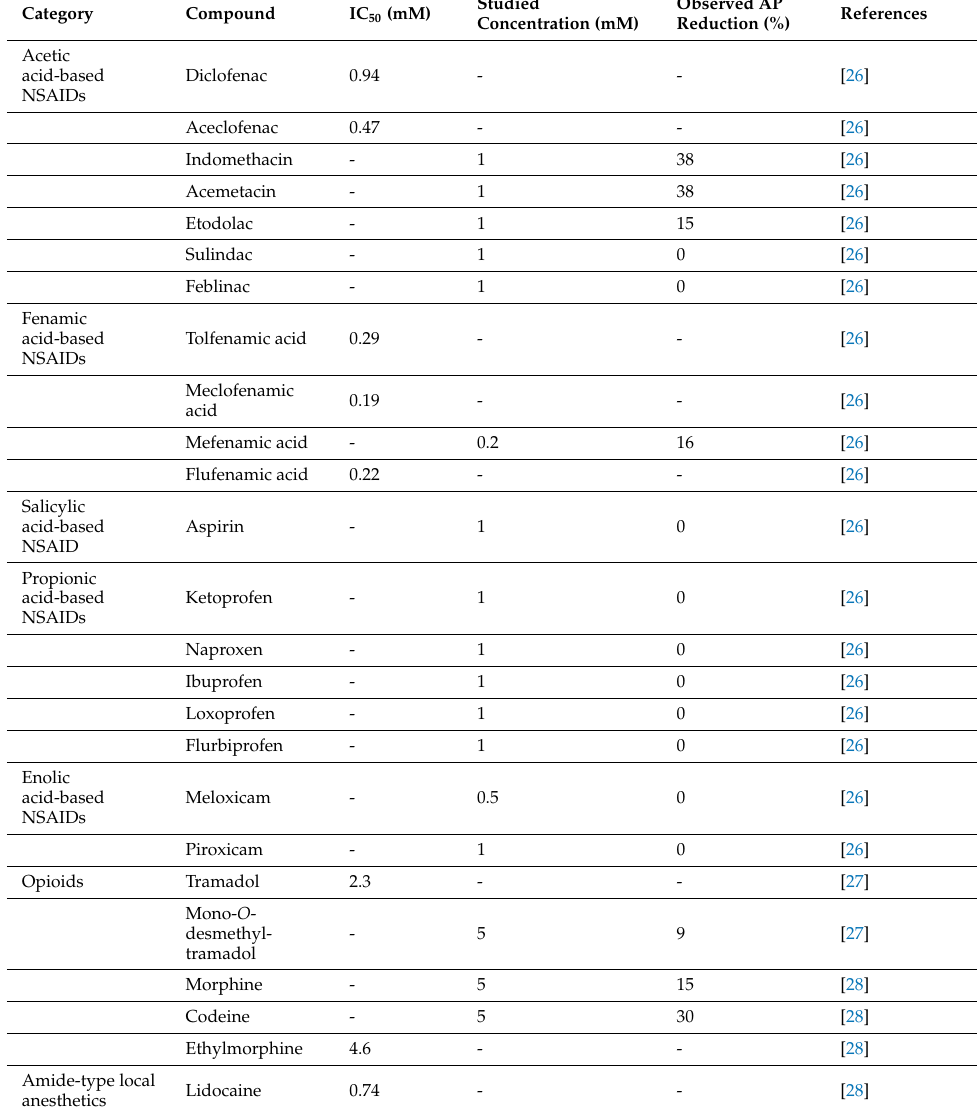
Table 1. Effects of clinical analgesics, analgesic adjuvants, and plant-derived chemicals on fast- conducting frog sciatic nerve